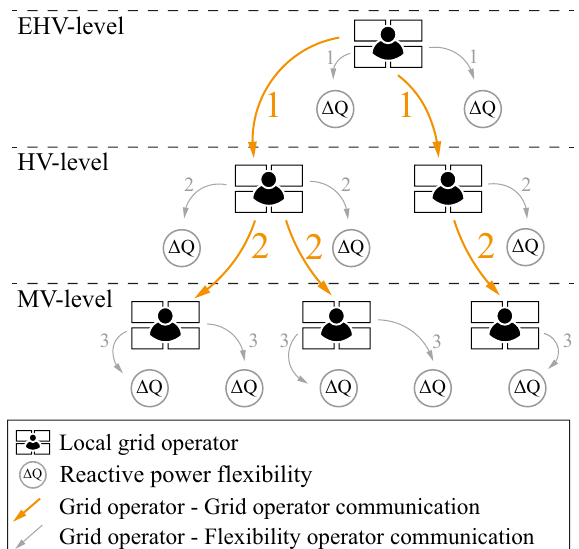
Fig. 2 Phase 2: Determination of reactive setpoints and payments by top-down